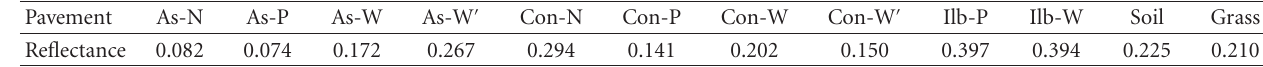
Table 3: Solar reflectance on each pavement surface (dry surface condition).